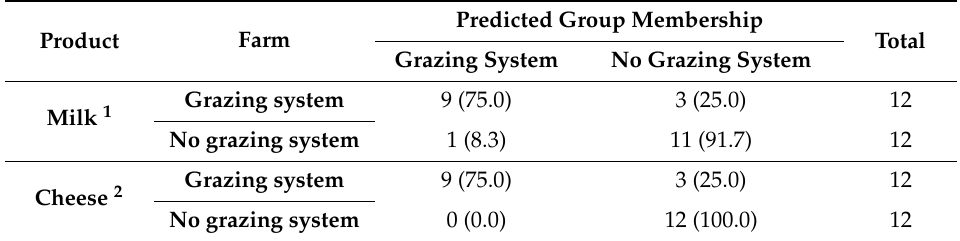
Table 5. Classification results of milk and cheese samples after cross validation. The table crosses the original classification (in the rows) with that obtained from the solution of the discriminant analysis (in the columns) to examine the validity of the solution. Values are number and percentage. Predicted Group Membership Total Product Farm Grazing System No Grazing System Milk 1 Grazing system 9 Cheese 2